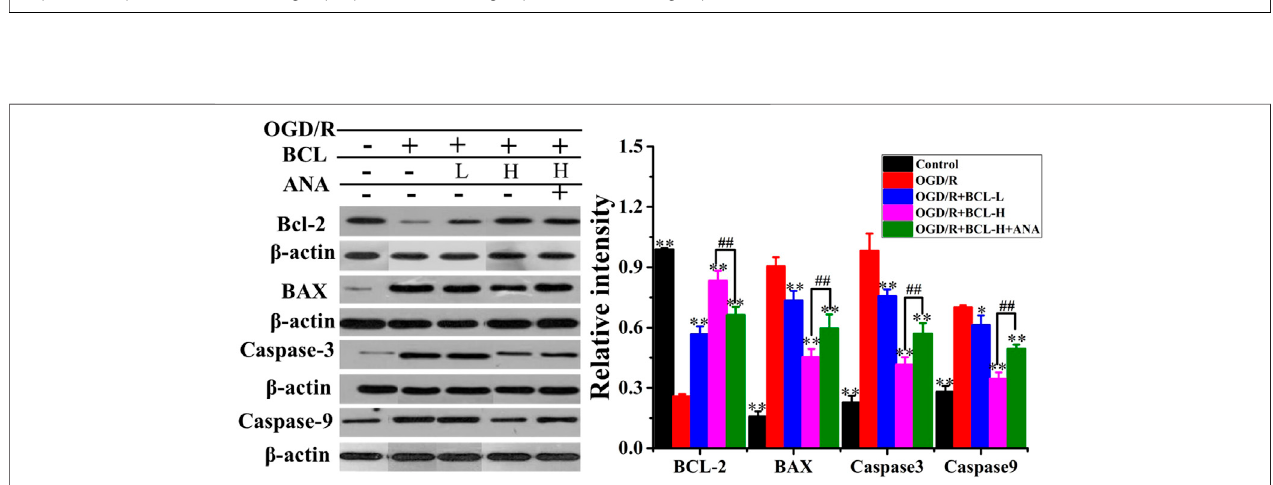
FIGURE7| EffectsofBCL(34.38 μ g/mland8.59 μ g/ml)andTrkBantagonistonneuronsintheNAsystemafterOGD/R. (A – B) TheeffectofBCLontheexpression of MAP2. (C) Neuronal morphology in the control group. (D) Neuronal morphology in the OGD/R group. (E) Neuronal morphology in the OGD/R + BCL-L group. (F) Neuronal morphology in the OGD/R + BCL-H group. (G) Neuronal morphology in the OGD/R + BCL-H + ANA group. Quanti fi ed results were normalized to β -actin expression. ** p < 0.01, vs. OGD/R group, # p < 0.05, BCL-H group vs. BCL-H+ANA group.